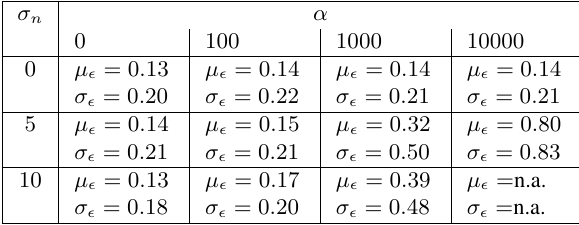
Table 6: Influence of tachymeter measurements for test scene I.